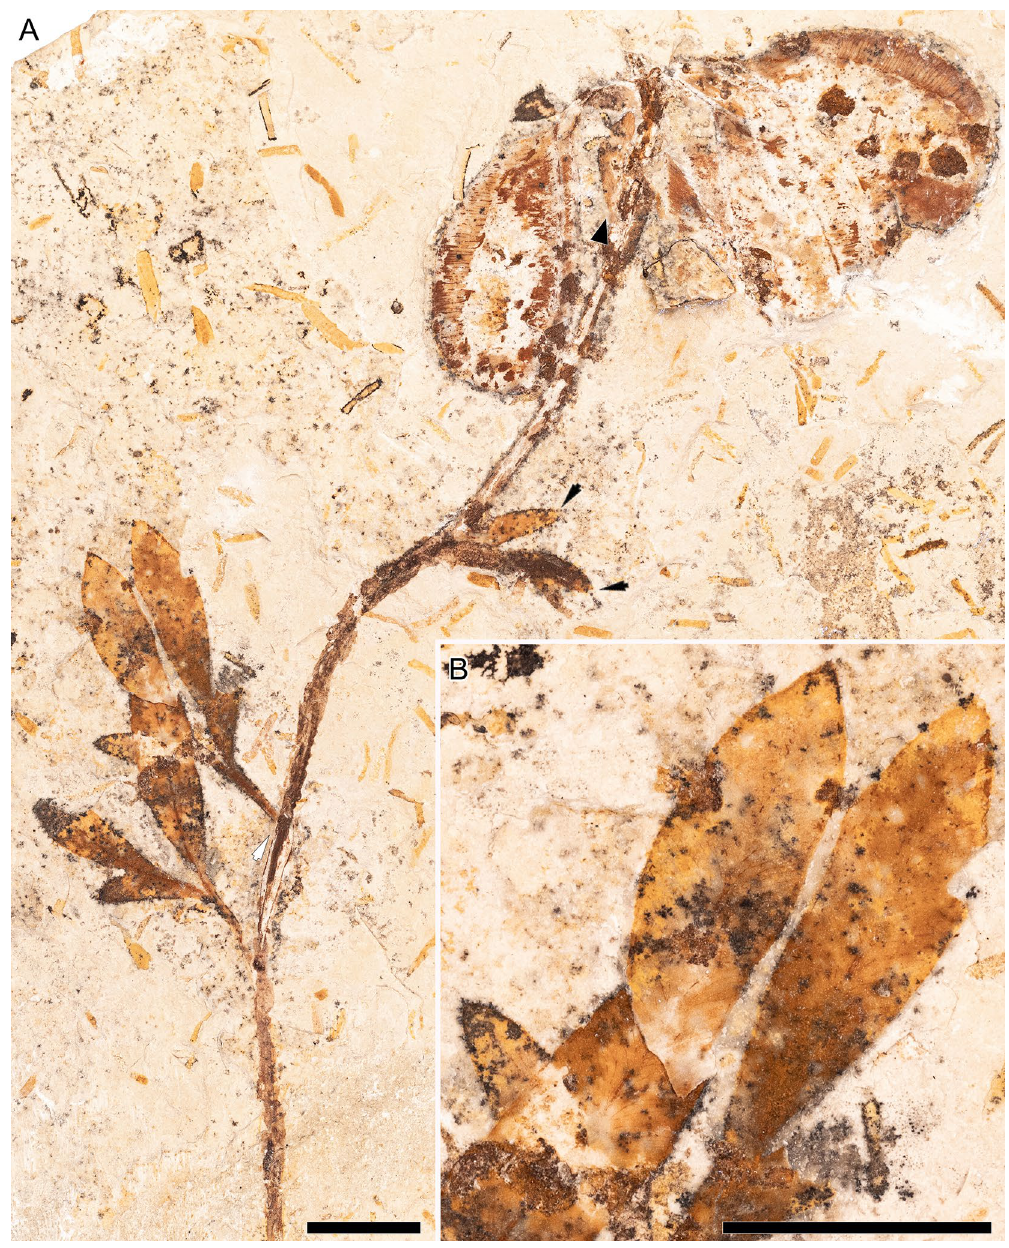
Figure 4. Santaniella acuta gen. nov. et sp. nov. ( A , B ) holotype (MB. Pb. 2000/71). ( A ) general view of holotype showing four leaves (white arrow points to leaf attachment of the second proximal leaf of type II and black arrows to distalmost leaves of type I), and a terminal aggregate fruit surrounded by only one persistent perianth- like organ (black triangle). ( B ) close-up on leaf showing details of venation and apices. Scale bars: 1